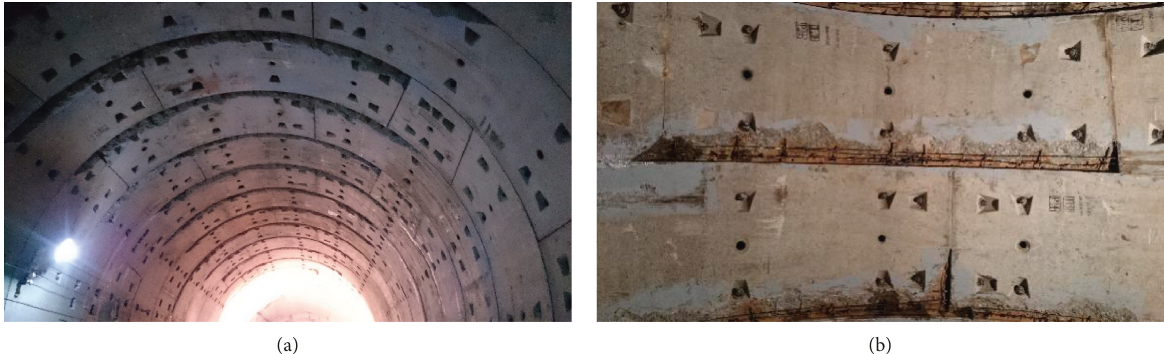
Figure 3: The investigated picture for the disease of concrete spalling on the scene. (a) Multiple successive ring spalling on the vault. (b) Regional concrete spalling.